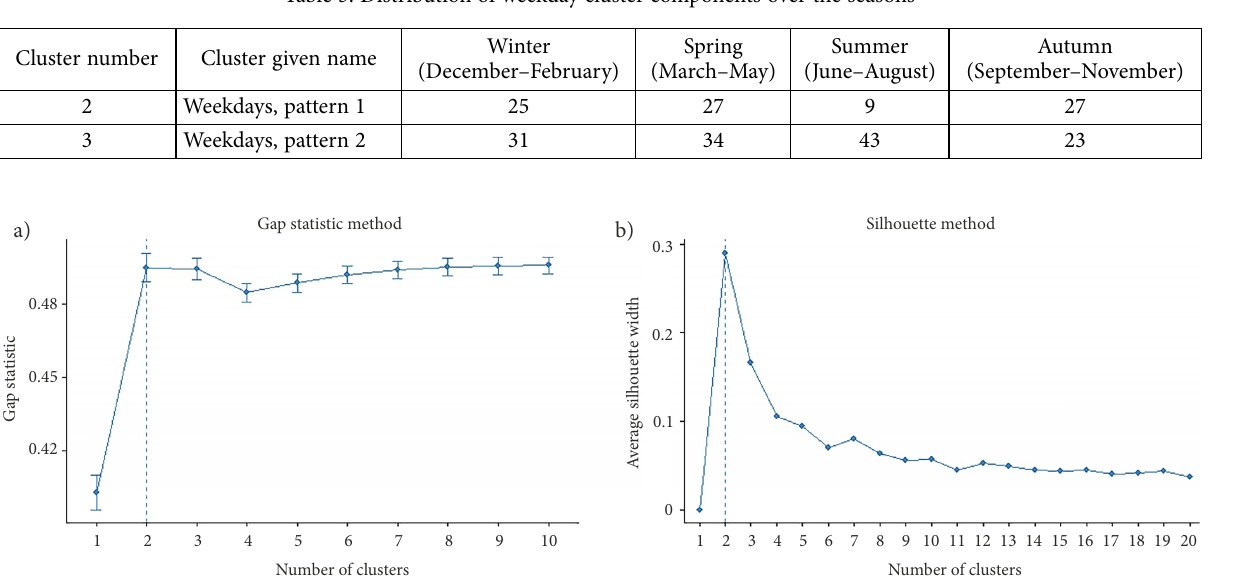
Figure 7. Gap statistics and average silhouette width charts for mobility patterns